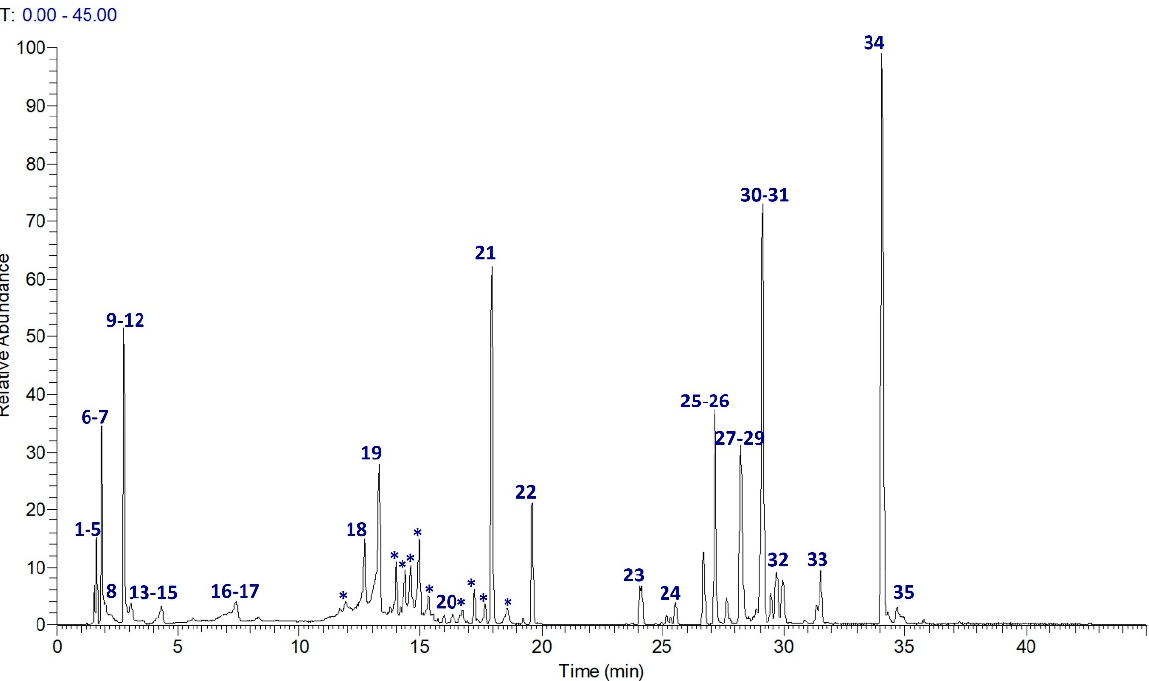
Figure 1. Extracted ion chromatogram of the main metabolites identified in JasHEx. Those indicated by * were included in Molecular Networks (MNs).